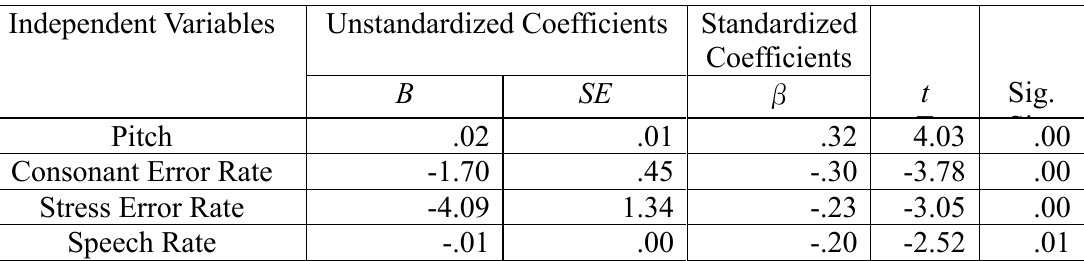
Stepwise Multiple Regression Analysis between Accentedness Ratings and Seven Speech Characteristics (Japanese Judges